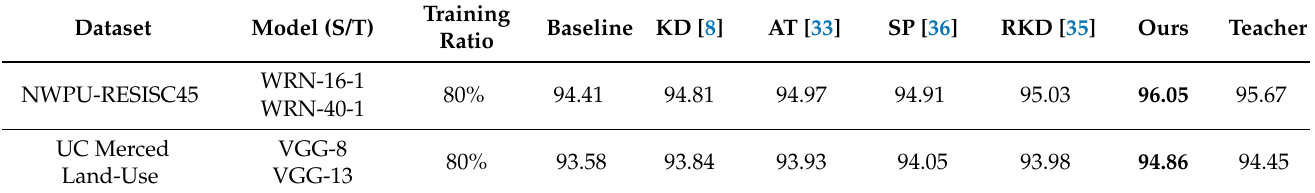
Table 5. Overall accuracy (%) on the NWPU-RESISC45 and UC Merced Land-Use datasets. We employ different model series for comparison. WRN-40-1/WRN-16-1 is used for the teacher/student combination on the NWPU-RESISC45 dataset. Furthermore, VGG-13/VGG-8 is used for the teacher/student combination on the UC Merced Land-Use dataset. The most recent methods are compared in our experiments. The best result in each experiment is shown in bold.